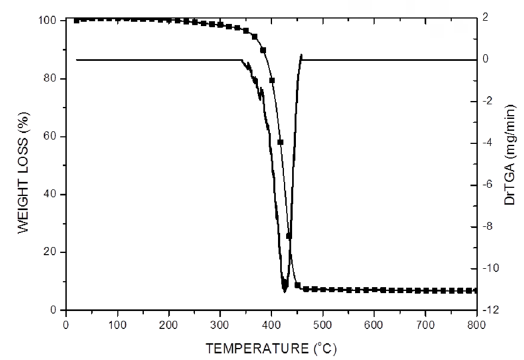
Figure 2. Thermogravimetrical analysis TGA and drTGA for latex beads.